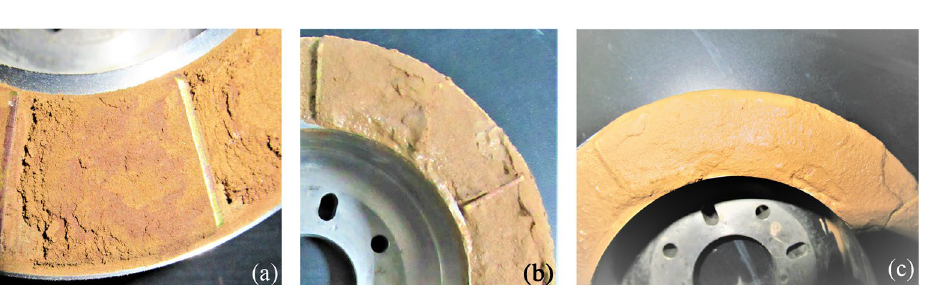
Figure 10. Relationship between shear strength and moisture content. ( a ) Peak shear strength; ( b ) residual shear strength.